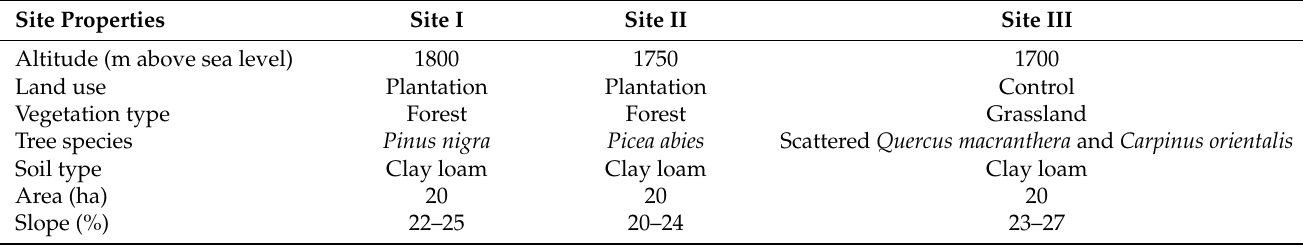
Table 1. Description of geographical characteristics of the study